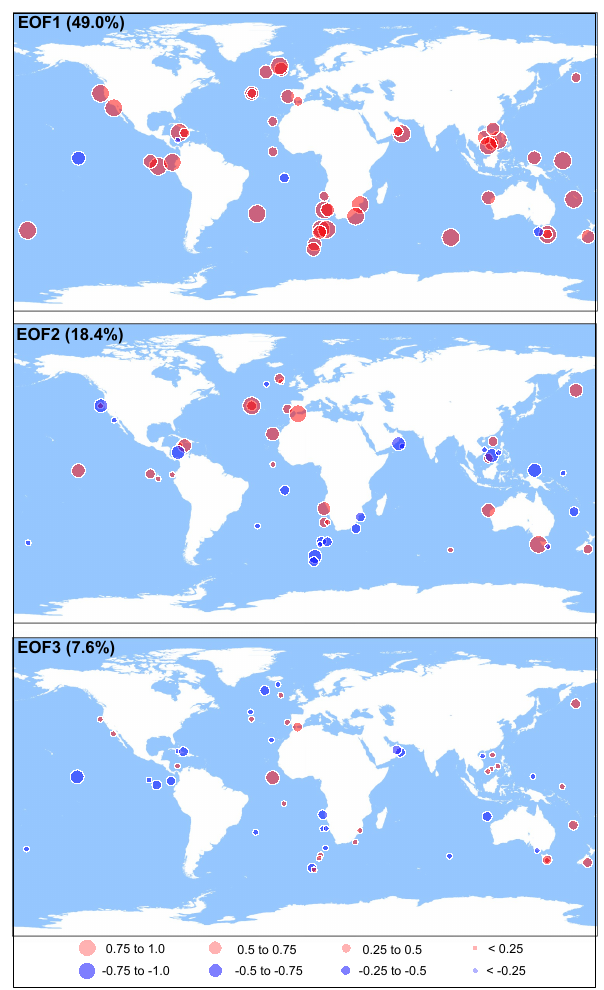
Fig. 5. Spatial distribution of the mean loadings of the first three EOFs, based on 1000 iterations using an age and a temperature un- certainty of 5kyr and 1 ◦ C. Positive loadings are given in red, neg- ative loadings in blue. Variance explained by each component is given in brackets. Almost all records show high positive loadings on the first EOF, while high positive loadings on the second EOF are restricted to the North Atlantic Ocean and the Mediterranean Sea, and south of